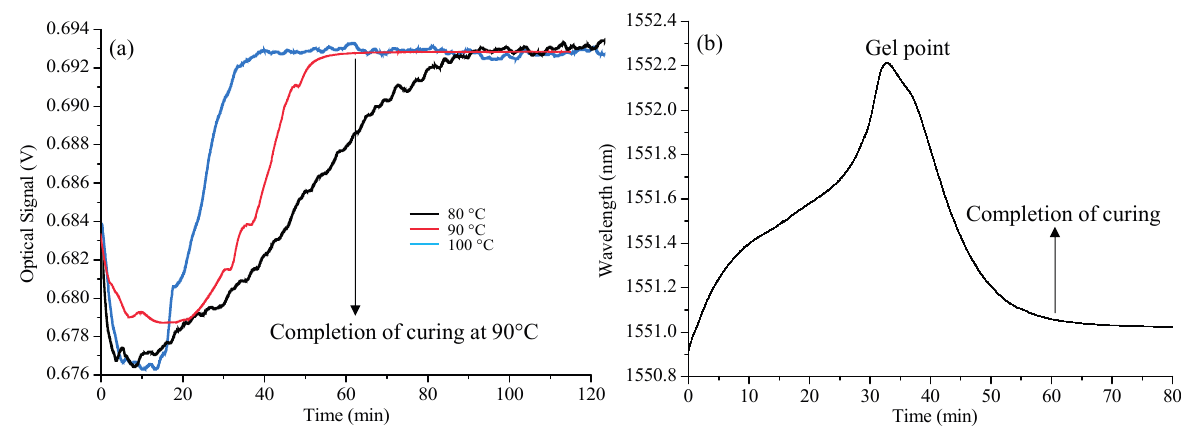
Figure 5. Sensor outputs (( a ): Fresnel at 80, 90, and 100 °C, ( b ): fiber Bragg grating (FBG) at 90 °C).